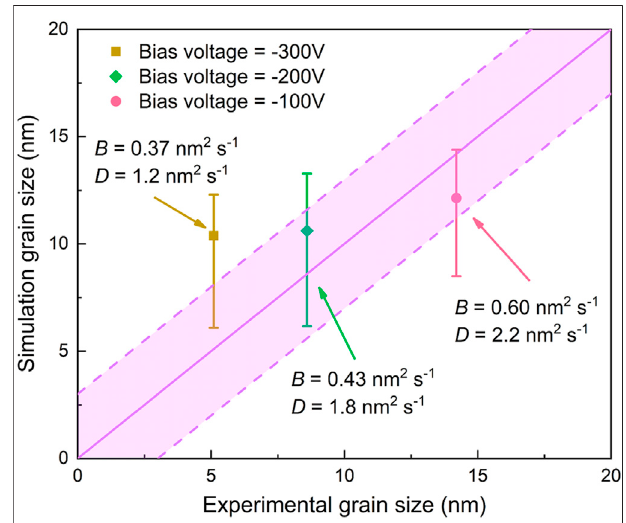
FIGURE 7 | Comparison of the grain size of TiN coatings between the phase- fi eld simulation results during PVD growth applying different vapor- solid transition velocities (i.e., B ) and diffusion coef fi cients (i.e., D ) and the experimental data with various bias voltage (Wang et al.,